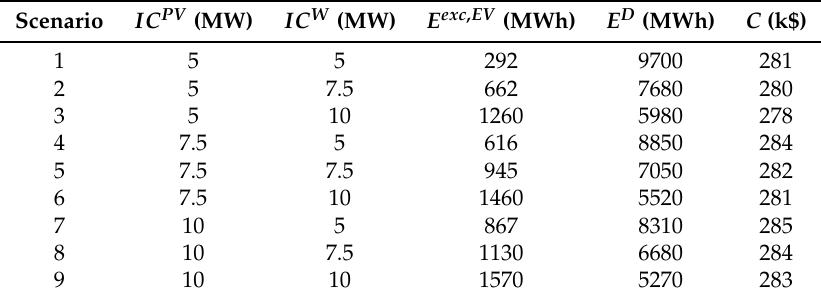
Table 7. Energy and Costs comparison between each